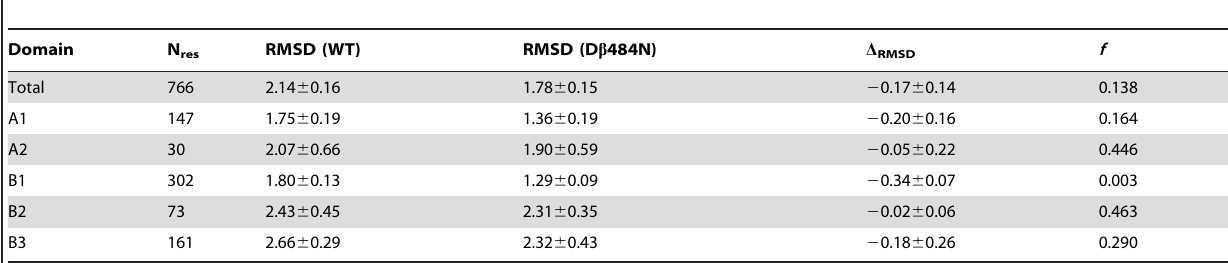
Table 4. Modeling of the wild type (WT) and the mutant (D b 484N) Ec PA stability at pH 10.0.